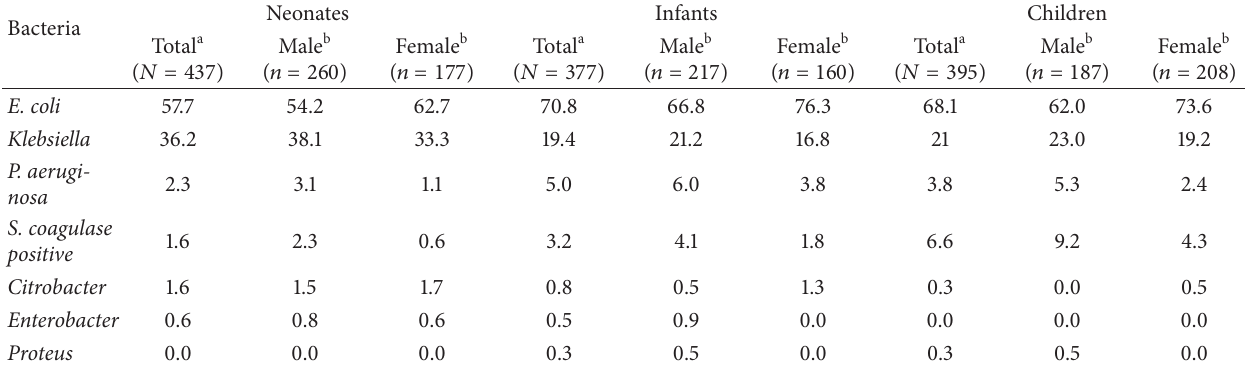
Table 1: The main bacterial pathogens implicated in urinary tract infection by sex and age throughout the study period. Bacteria